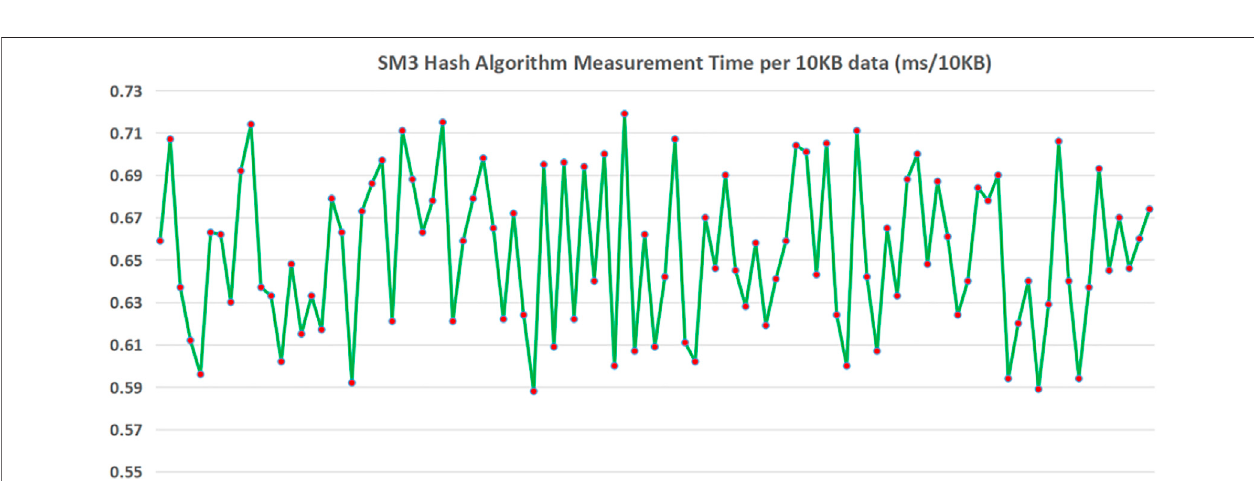
FIGURE 10 | A malicious program “ portmap.cid ” is identi fi ed as an illegal program.